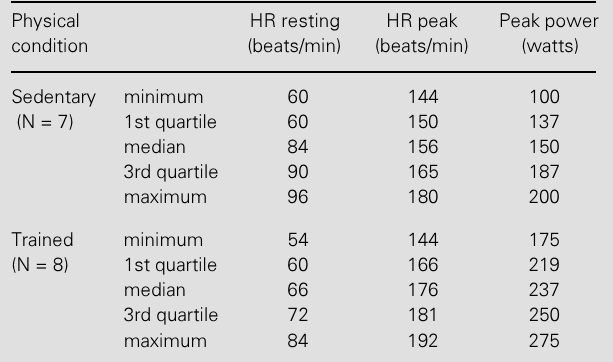
Table 2 - Functional data of the subject groups